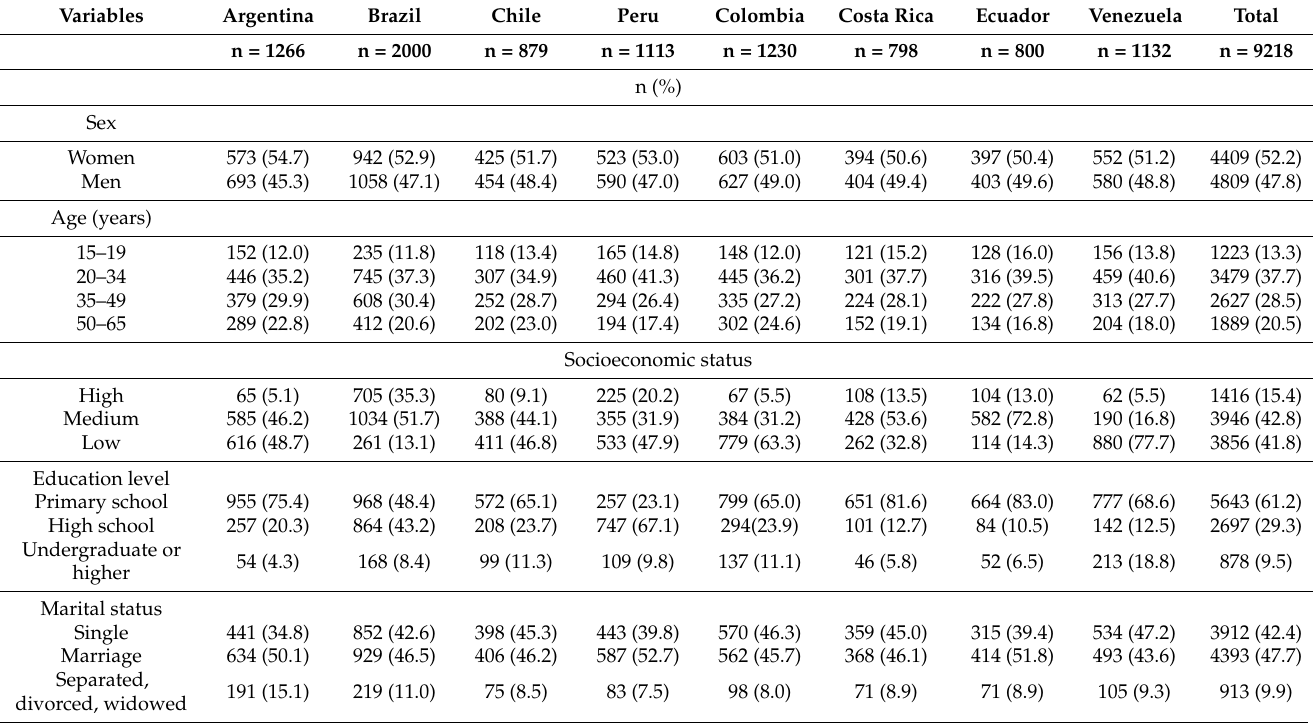
Table 1. Sociodemographic characteristics of the Latin American population. Latin American Health and Nutrition Study/Estudio Latino Americano de Nutrici ó n y Salud (ELANS).